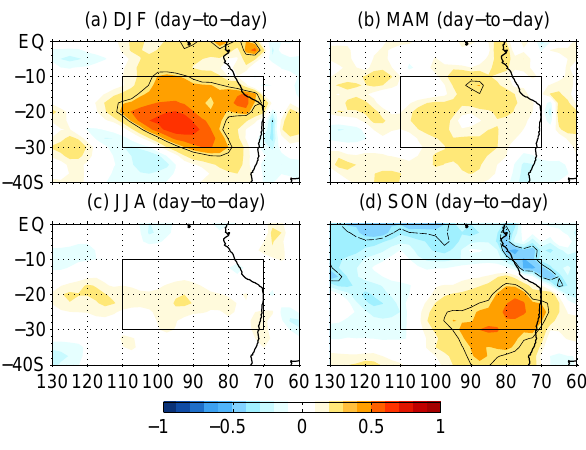
Fig. 9. Correlation of daily area-averaged adjusted low cloud amount with daily LTS at each grid point for (a) DJF, (b MAM, (c) JJA and (d) SON of 2000. Contour line denoting the 95% sig- nificance level using the Student-t test is